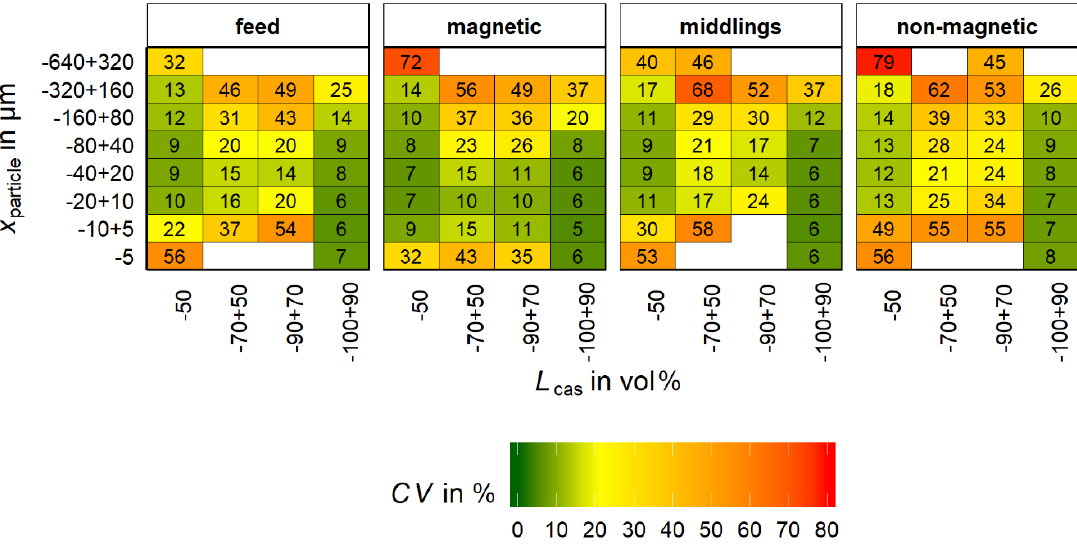
Figure 10. Coefficient of variation ( CV ) for the bins of x particle classes and L cas based on data from bootstrap resampling; green: 0%, yellow: 20%, red: 80%). The numbers in the boxes indicate the value of CV for each bin.